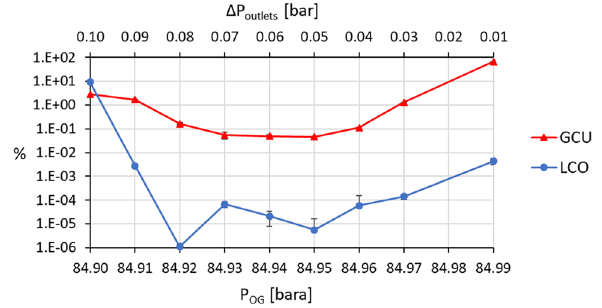
Fig. 7 Comparison curve of LCO and GCU with respect to the gas outlet pressure (P OG